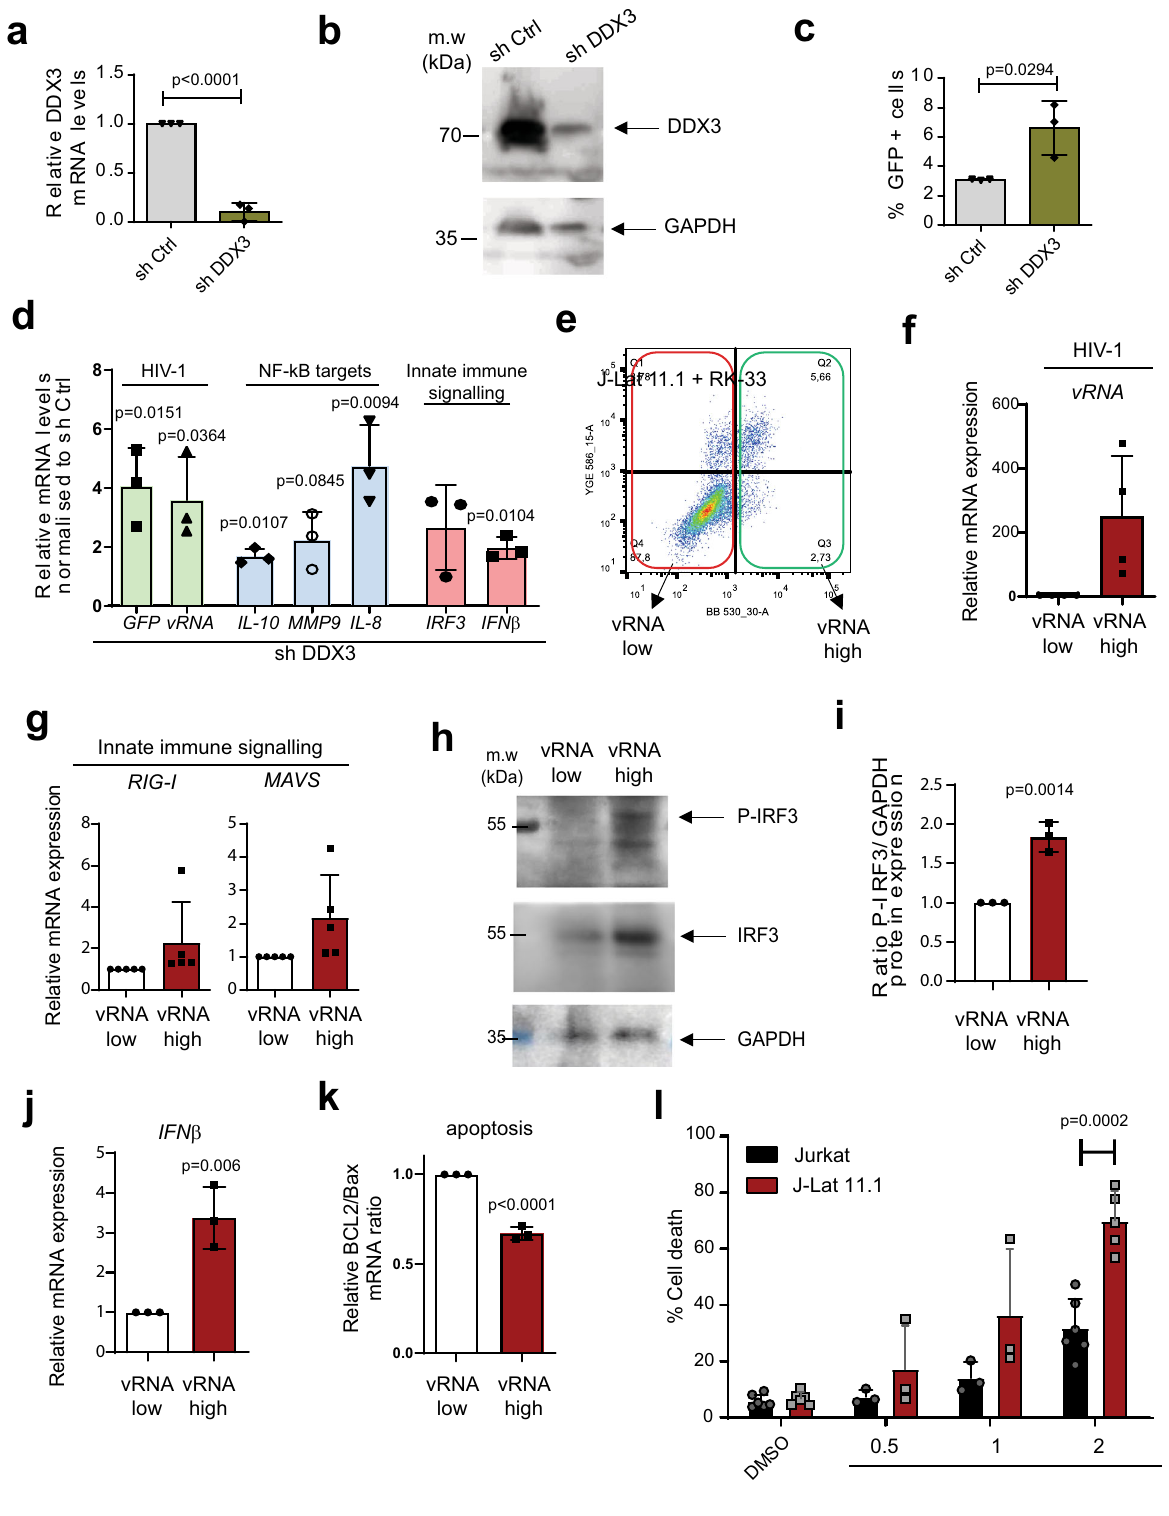
vRNA-expressing cells have a higher susceptibility to undergo stained with Hoescht 33342 and the percentage of viable cells was apoptosis (Fig. 2k). To further probe the selectivity of cell death, quanti fi ed by fl ow cytometry. We observed a dose-dependent J-Lat 11.1 cells and parental Jurkat cells lacking integrated HIV-1 increase in cell death in RK-33-treated J-Lat cells compared to provirus and vRNA were treated with increasing concentrations parental Jurkat cells, most strikingly at 2 µM RK-33 (Fig. 2i). In of RK-33 (0.5 – 2 µM). Eighteen hours post-treatment, cells were this condition, cell death was observed in 70% of J-Lat 11.1 cells, NATURE COMMUNICATIONS| (2021) 12:2475